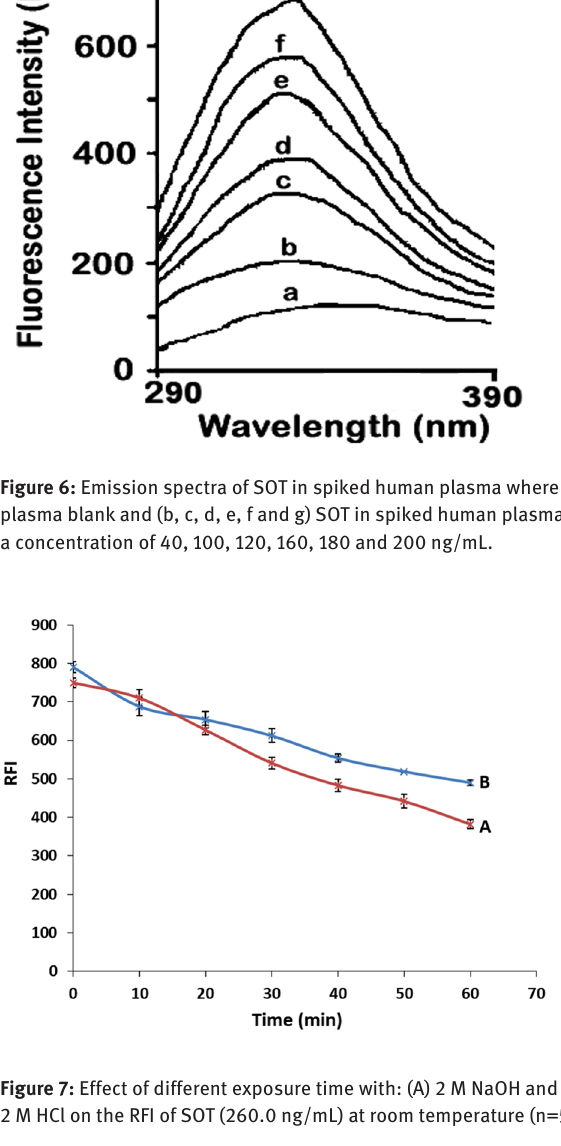
Table 5: Assay results for the determination of SOT in spiked human plasma samples using the proposed method.